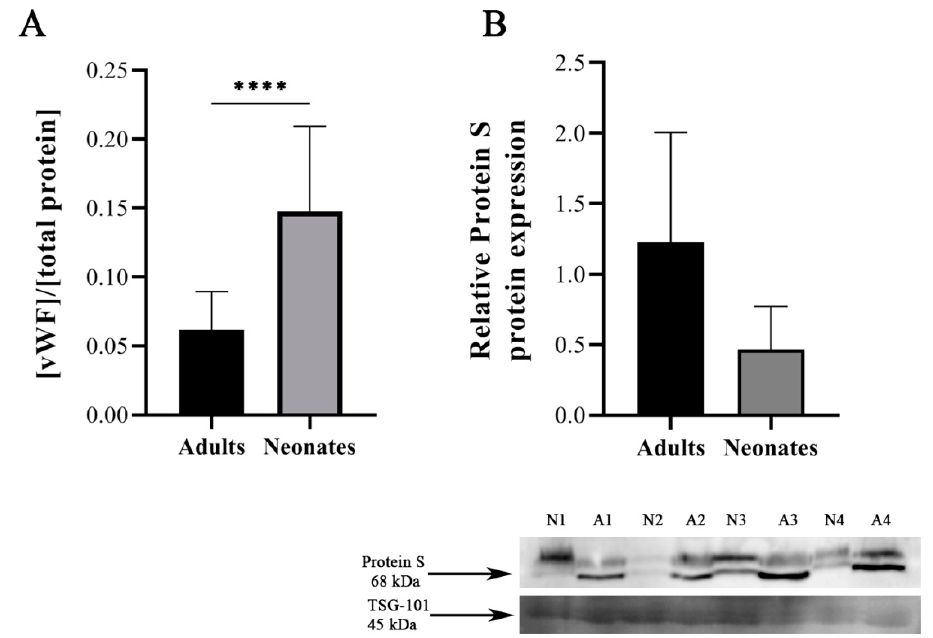
Figure 5. Validation of differential protein expression in independent samples. ( A ) vWF levels detected by ELISA in exosomes of adults ( n = 10) and neonates ( n = 10). ELISA analysis reveals statistically significant differences in von Willebrand factor (vWF) concentrations (Mann–Whitney U test). **** p < 0.0001. ( B ) Western blot of protein S in plasmatic exosomes from adults (A; n = 4) and neonates (N; n = 4) (unpaired t -test, one-tailed). Tumor susceptibility gene 101 (TSG-101) was